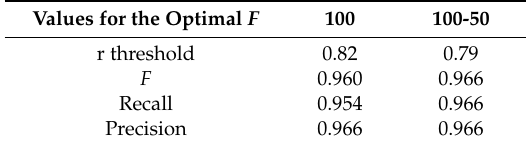
Table 6. Values for the optimal parameters selected from previous sections.